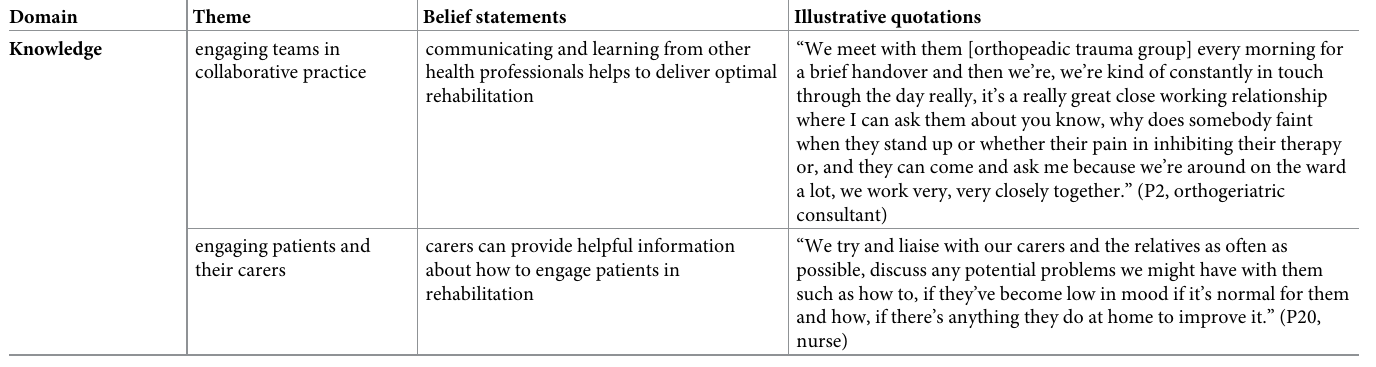
Table 2. Domains of the Theoretical Domains Framework as they relate to themes and belief statements, with supporting quotes from multidisciplinary participants.